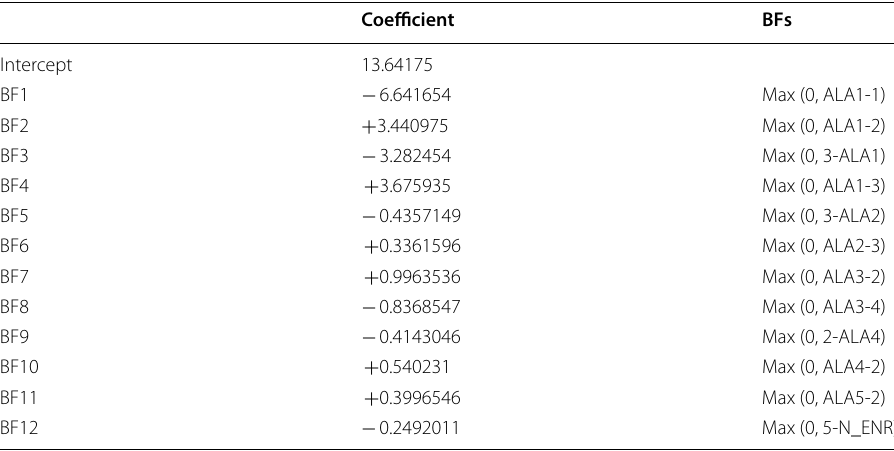
Table 14 BFs for the MARS model for Introduction to enterprise Coefficient BFs Intercept 13.64175 −